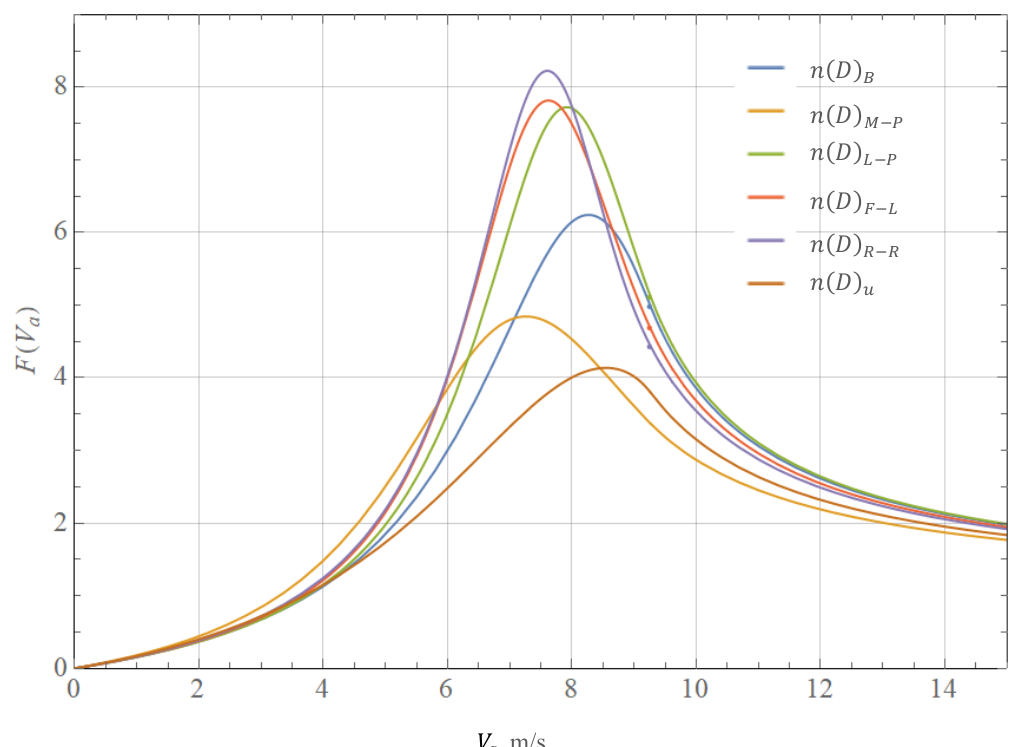
Figure 4. Dimensionless pressure drop in the shaft vs. the air flow velocity for various types of droplet distribution.